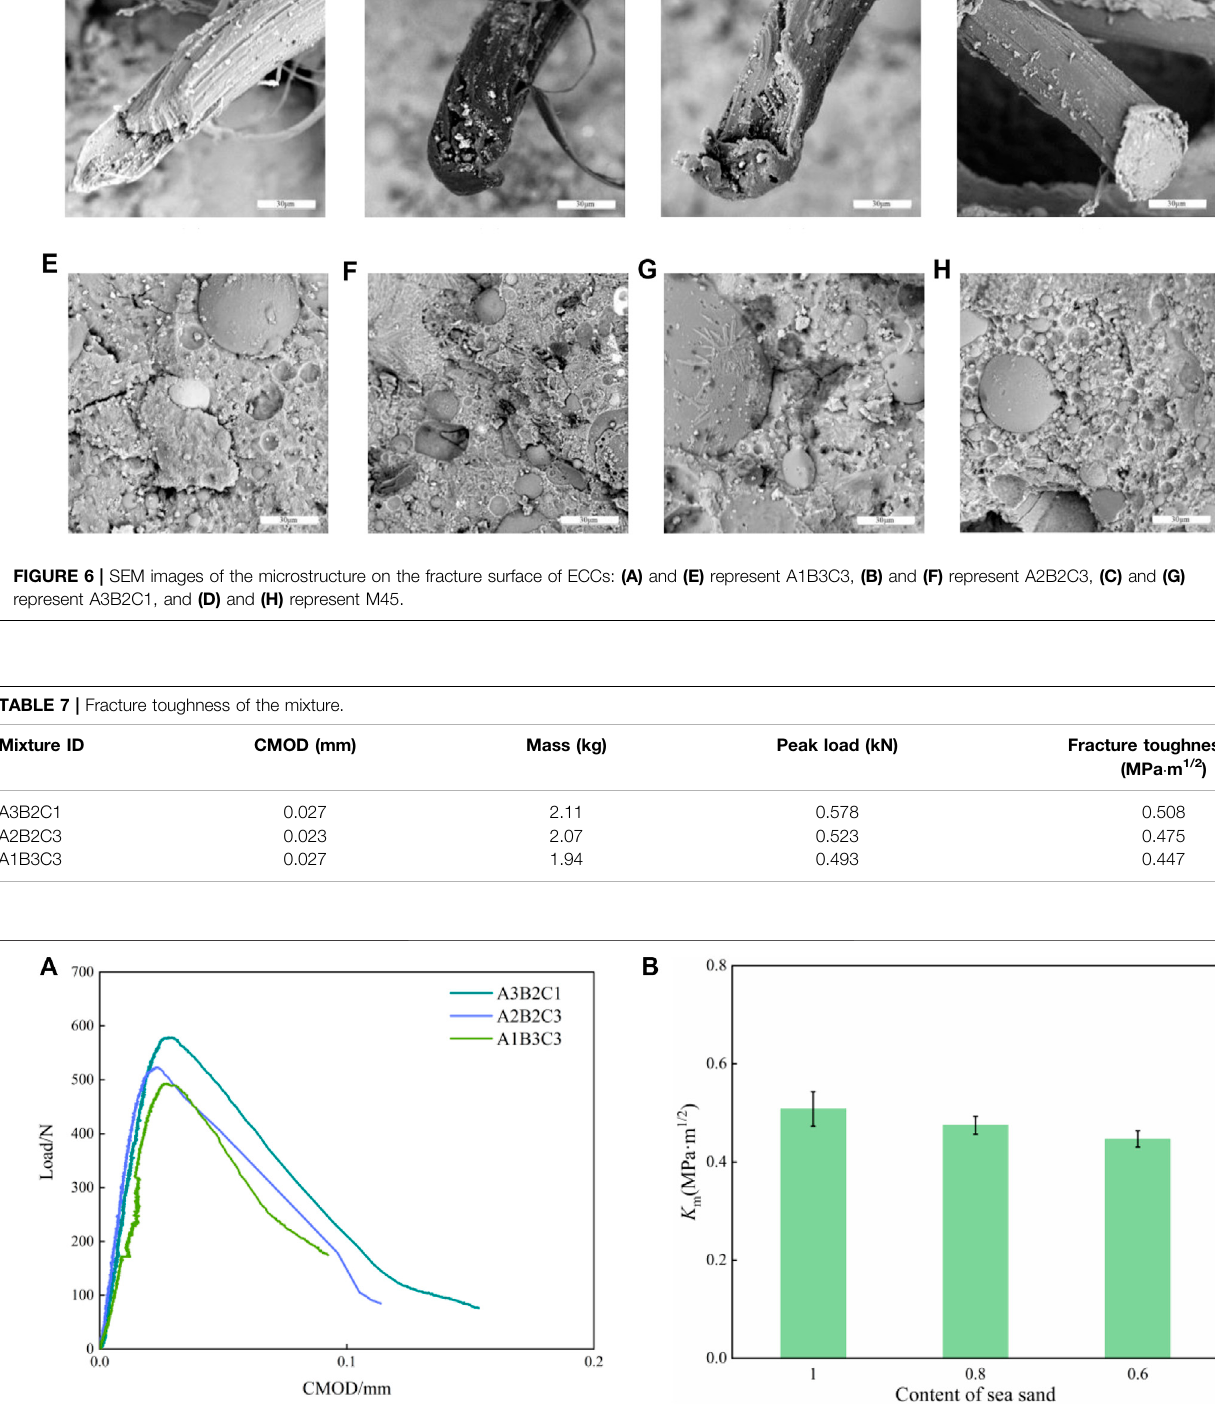
Frontiers in Materials |